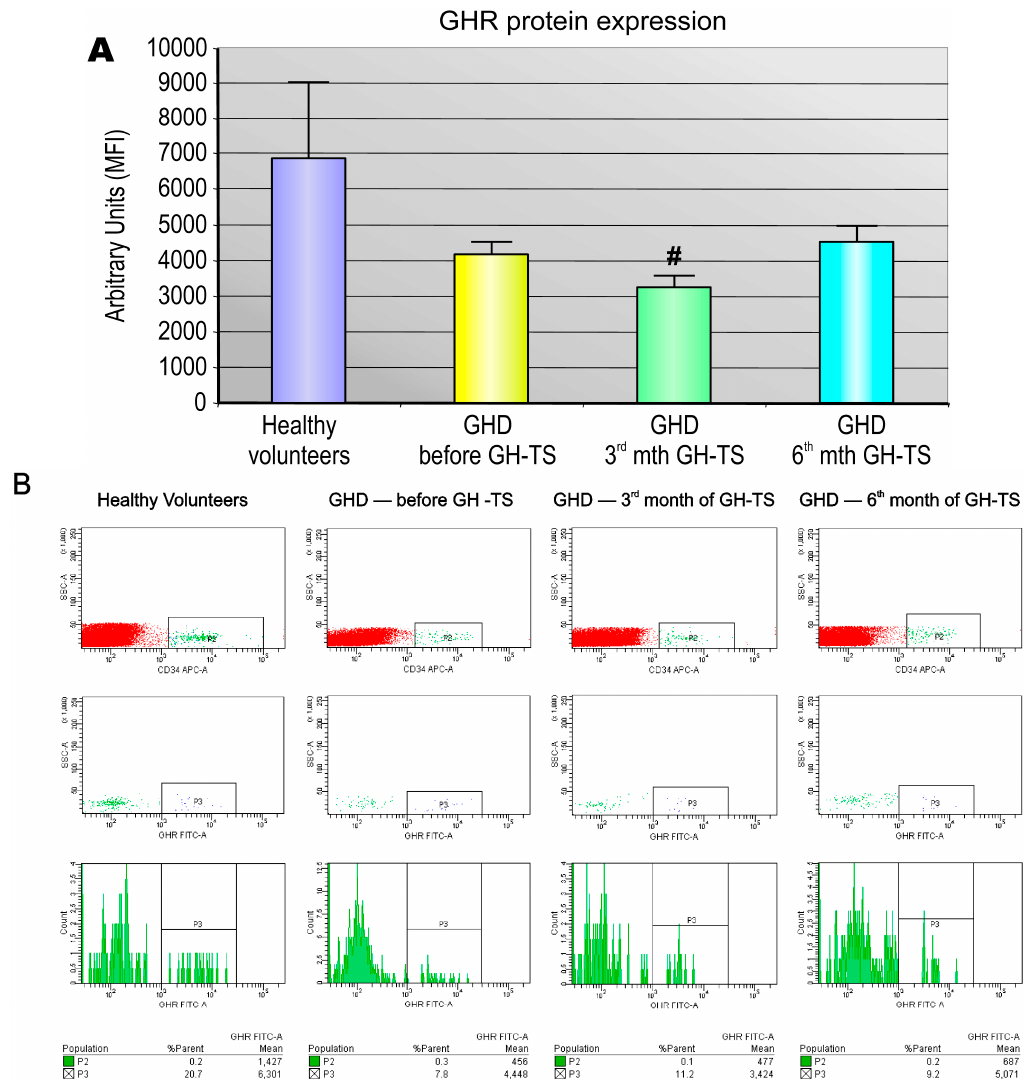
Figure 2. Quantitative analysis of GHR protein density on CD34+ cells from GHD patients. The quantitative analysis of the expression of GHR receptors on the cell membrane surface of CD34+ cells from GHD patients in course of GH therapy was performed ( A ). CD34+ cells were collected from PB of from healthy controls and GHD patients at different time points (before GH-TS and in the 3rd and 6th month of GH-TS). Surface GHR protein expression was assessed by flow cytometric analysis based on the mean fluorescence intensity (MFI) of GHR staining of CD34+ cells. The results are expressed as the mean value ± S.D. # p < 0.05 vs. control group. Representative flow cytometric immunofluorescence histograms of GHR expression by CD34+ cells harvested from PB of healthy controls and GHD patients before GH-TS and in the 3rd and 6th month of GH-TS are presented ( B ).